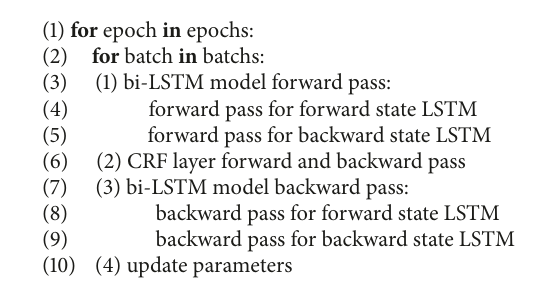
forward propagation, and backpropagation (BP)